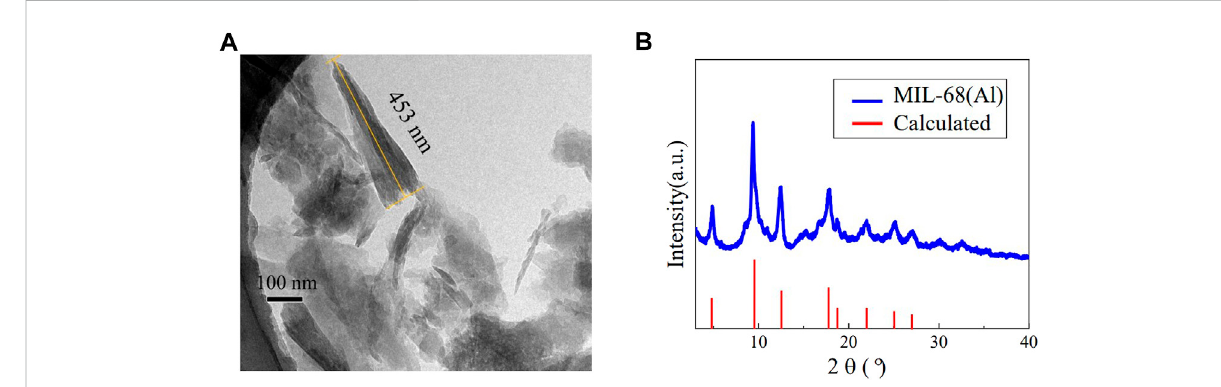
FIGURE 1 (A) TEM image of MIL-68(Al) with a 100 nm scale; (B) XRD pattern of as-synthesized MIL-68(Al).